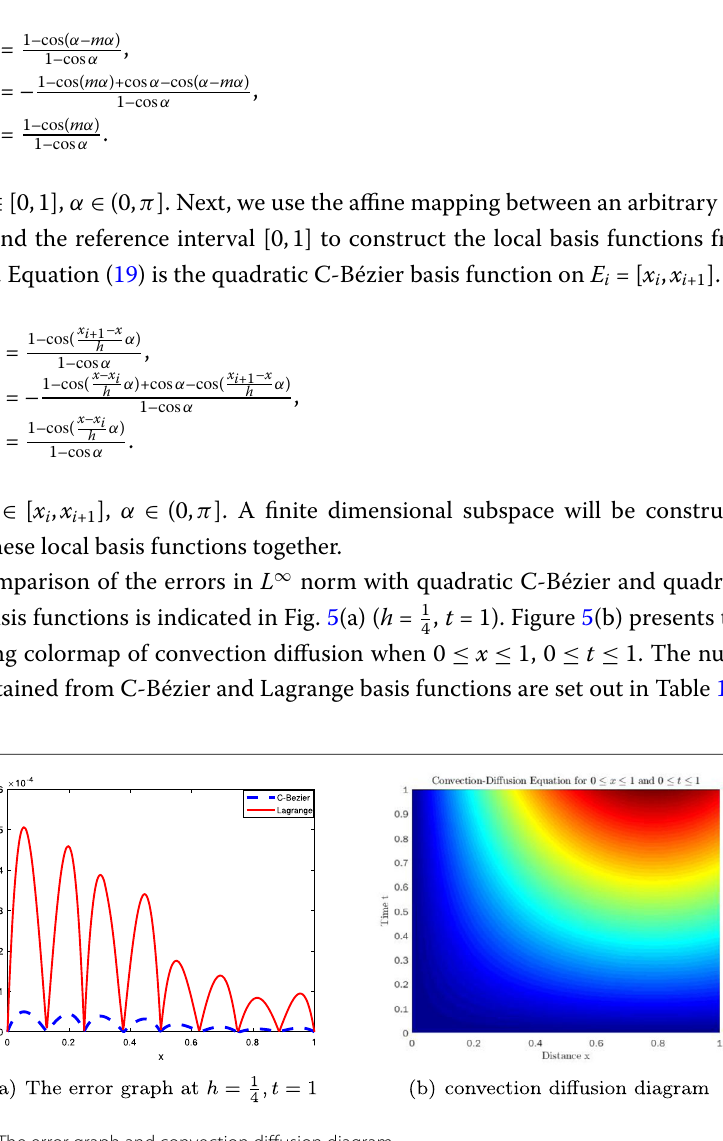
Figure 5 The error graph and convection diffusion diagram